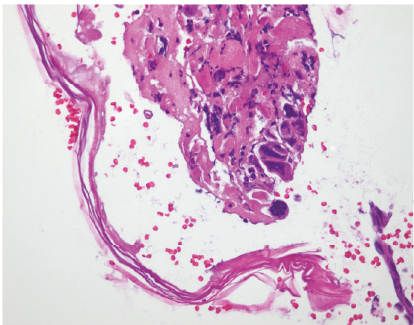
Figure 5: Skin biopsy: viral cytoplasmic effect including multinu- cleated cells and marginalization of